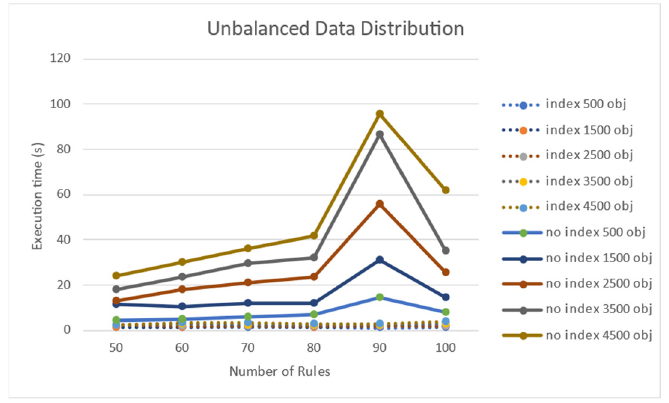
Figure 10. Performance effect of the number of rules on a non-uniform object distribution.